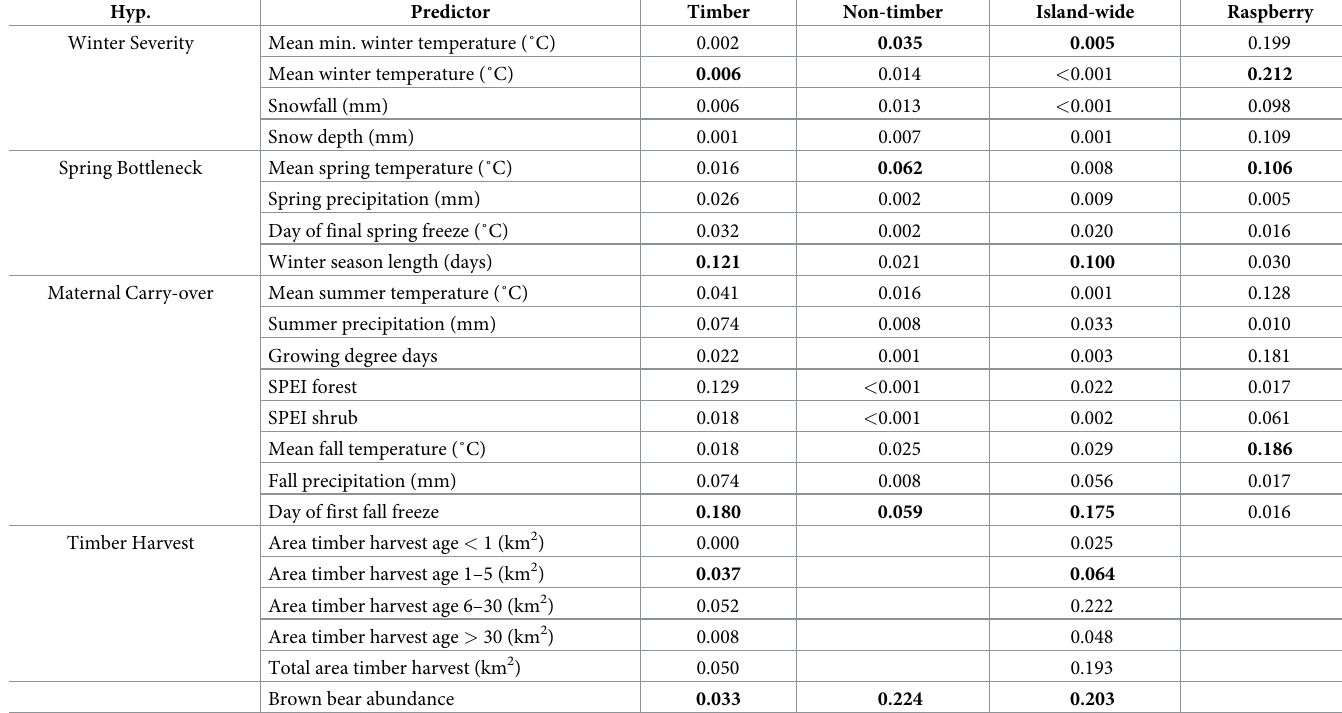
Table 2. Standardized regression coefficients (R 2 ) from univariate models predicting elk recruitment and abundance. Hyp.